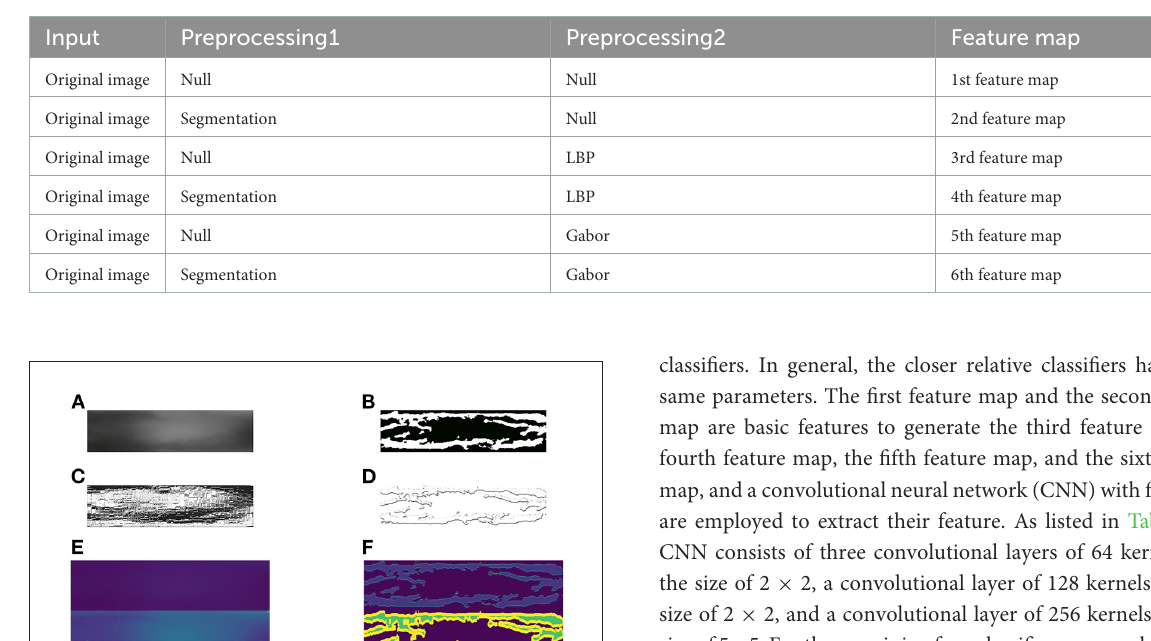
TABLE 1 Feature maps.